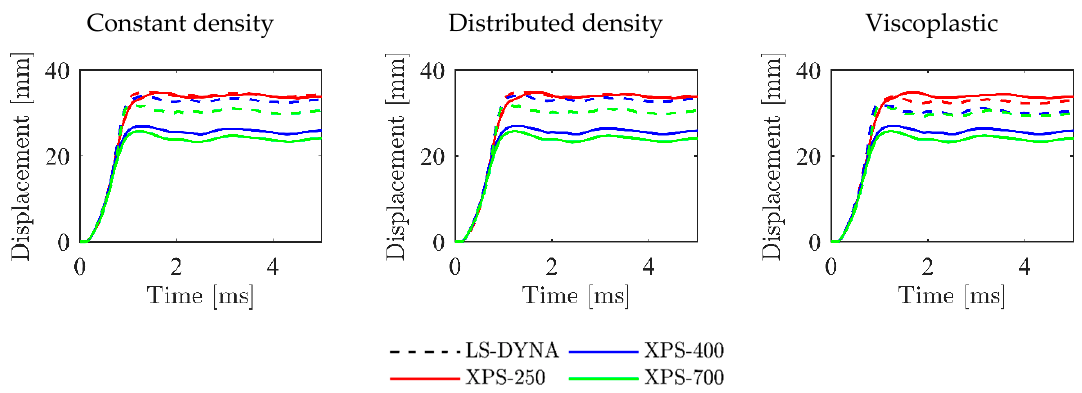
Figure 18. Comparison between experimental and numerical midpoint displacements for tests 10 bar firing with 10 bar firing pressure.